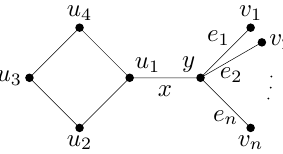
Figure 5: A unicyclic plane graph G with χ (cid:48)(cid:48)